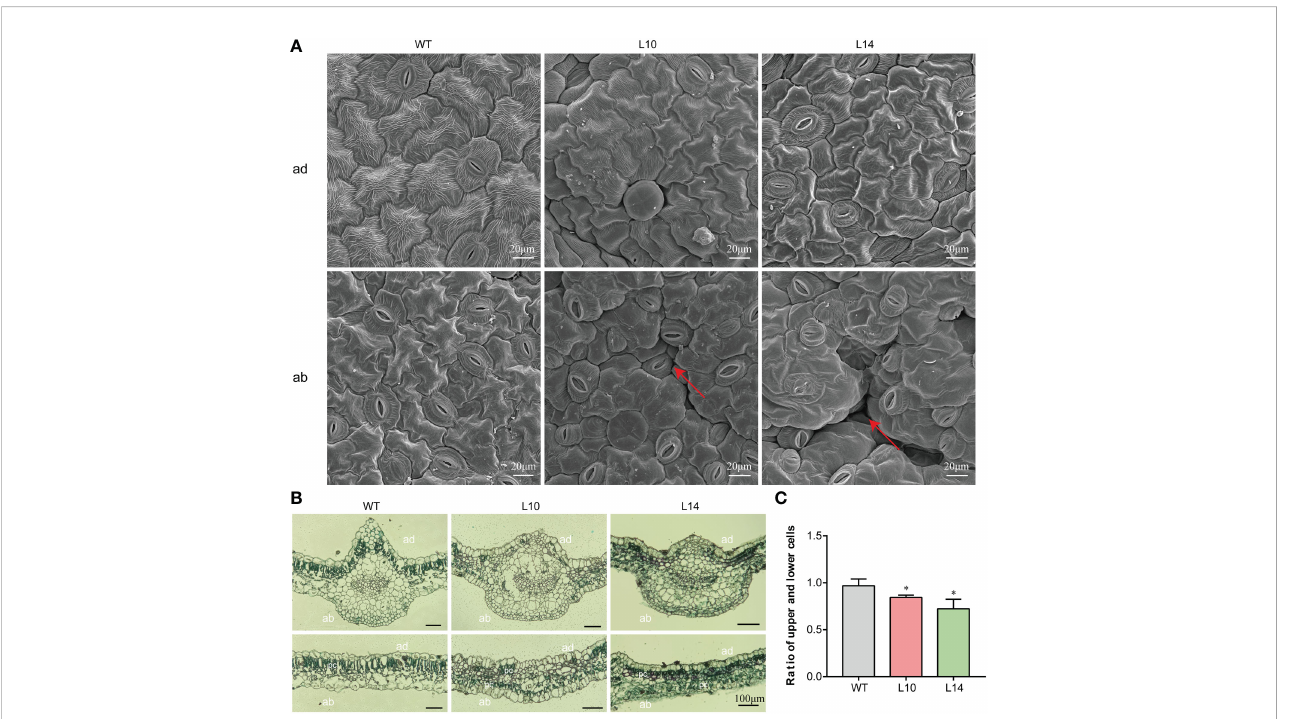
FIGURE 6 Cytological observations of the IbNAC43 -overexpressed and wild-type (WT) plants. (A) The adaxial and abaxial sides of the leaf were subjected to SEM. ad , adaxial side; ab , abaxial side. Scale bar , 20 m m. (B) Paraf fi n sections of leaves. pc , palisade cells. Scale bar , 100 m m. (C) The ratio of the upper to lower epidermal cells. Data are values from three independent experiments. Asterisk indicates a signi fi cant difference compared to the WT based on a Student ’ s t -test. * p <